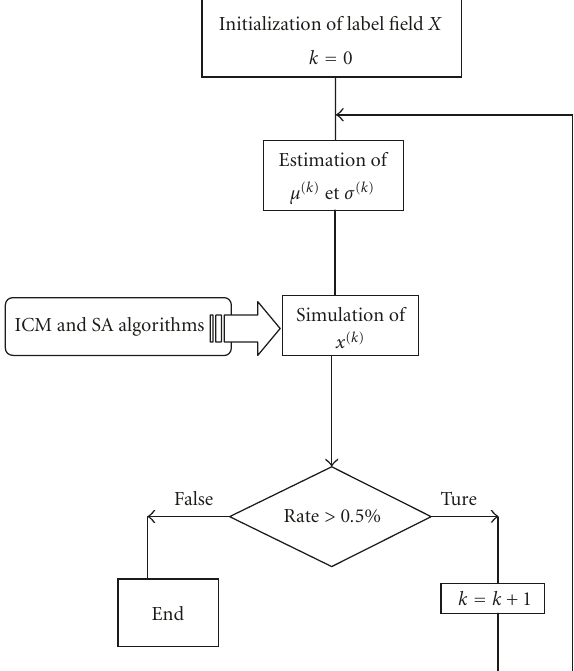
Figure 3: Mammographic image segmentation